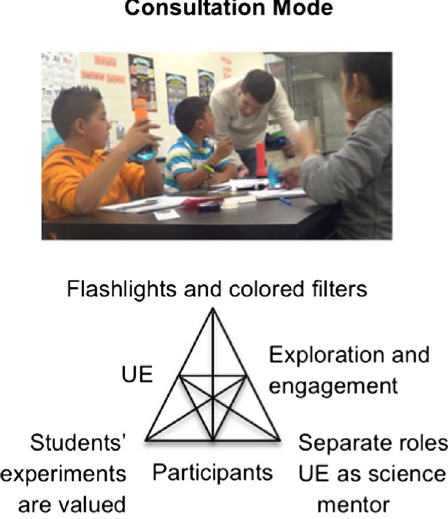
3. Consultation mode. Photo (top) shows Jorge and his group working on an activity to make colored light with flash- lights and filters. The triangle (bottom) shows the interconnected aspects of the system with Jorge as the